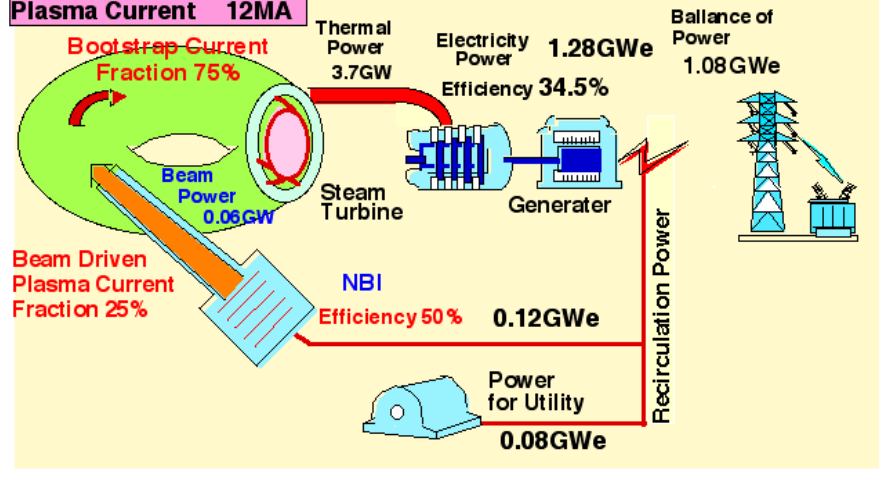
Figure 35. Principle to achieve high net generated power by achieving efficient continuous operation using bootstrap